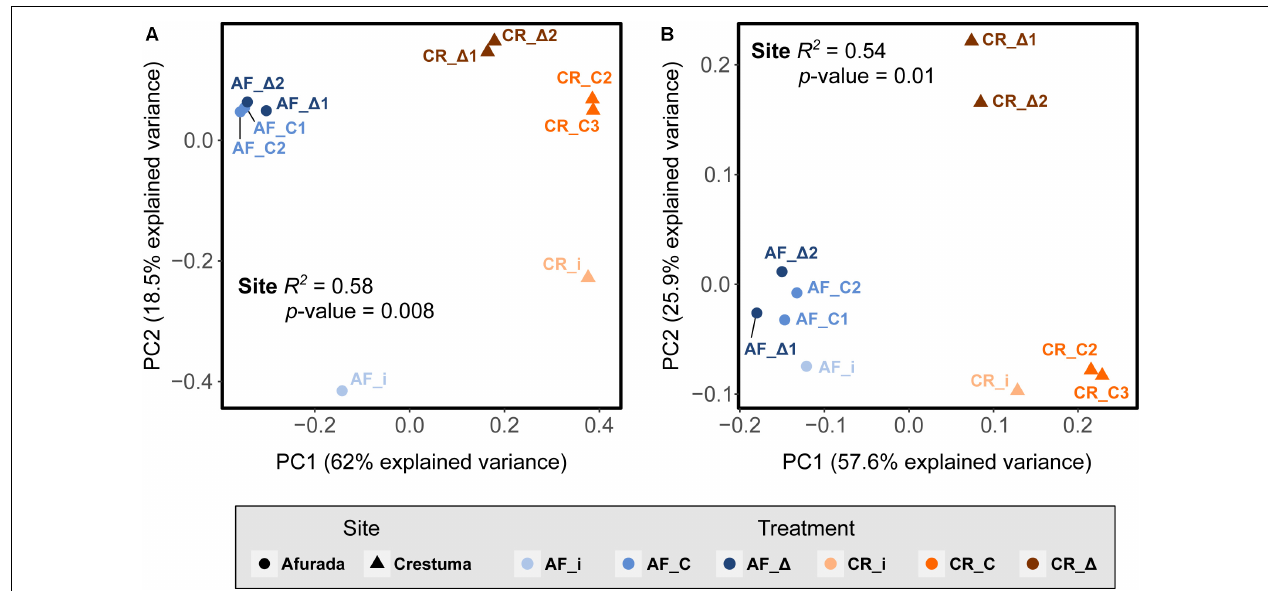
FIGURE 3 | Principal Coordinates Analysis (PCoA) of (A) unweighted and (B) weighted UniFrac distances of ASVs belonging to the top 10 phyla from the initial sediment (AF_i and CR_i) as well as in the sediment samples of the different salinity treatments (constant – AF_C and CR_C, and fluctuation – AF_ (cid:49) and CR_ (cid:49) ). The R 2 and P -values that resulted from the Adonis analysis of unweighted and weighted UniFrac distance matrices grouped by site and treatment are highlighted inside the PCoA. Samples were grouped by site (Afurada – AF_i, AF_C1, AF_C2, AF_ (cid:49) 1, AF_ (cid:49) 2; and Crestuma – CR_i, CR_C2, CR_C3, CR_ (cid:49) 1, CR_ (cid:49) 2) and treatment (Afurada in situ sample – AF_i; Afurada constant salinity – AF_C1, AF_C2; Afurada fluctuation salinity – AF_ (cid:49) 1, AF_ (cid:49) 2; and Crestuma in situ sample – CR_i; Crestuma constant salinity – CR_C2, CR_C3; Crestuma fluctuation salinity – CR_ (cid:49) 1, CR_ (cid:49) 2).